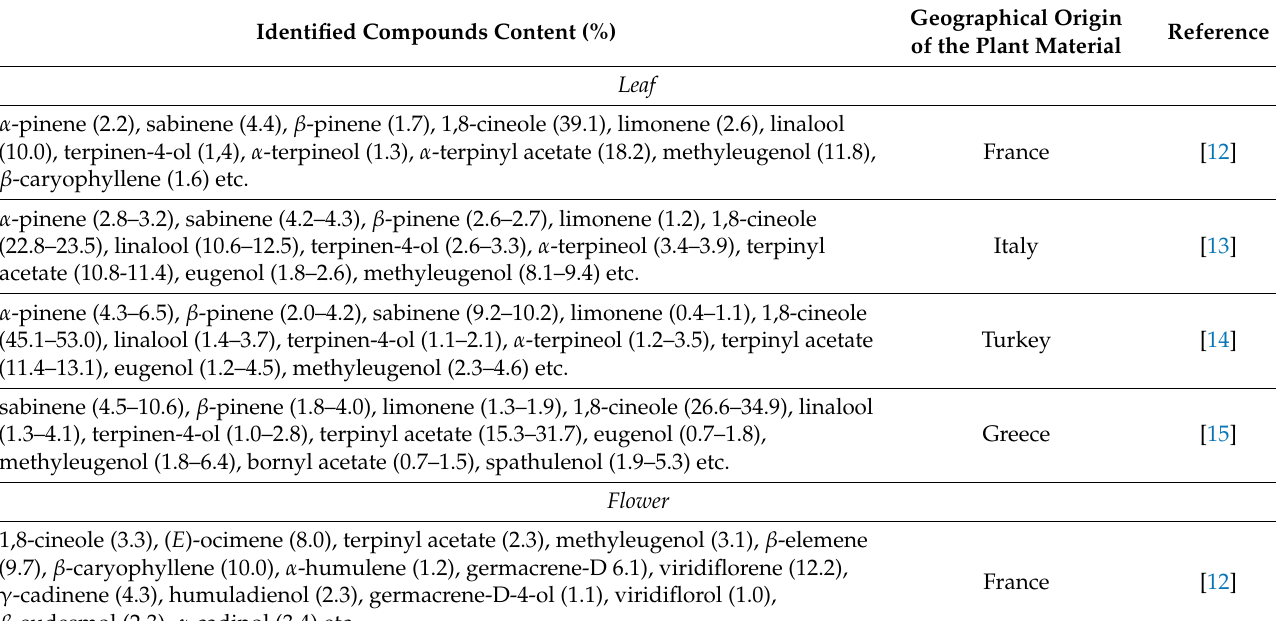
Table 1. Chemical composition and percent content of compounds identified in the EO from different organs of Mediterranean origin bay